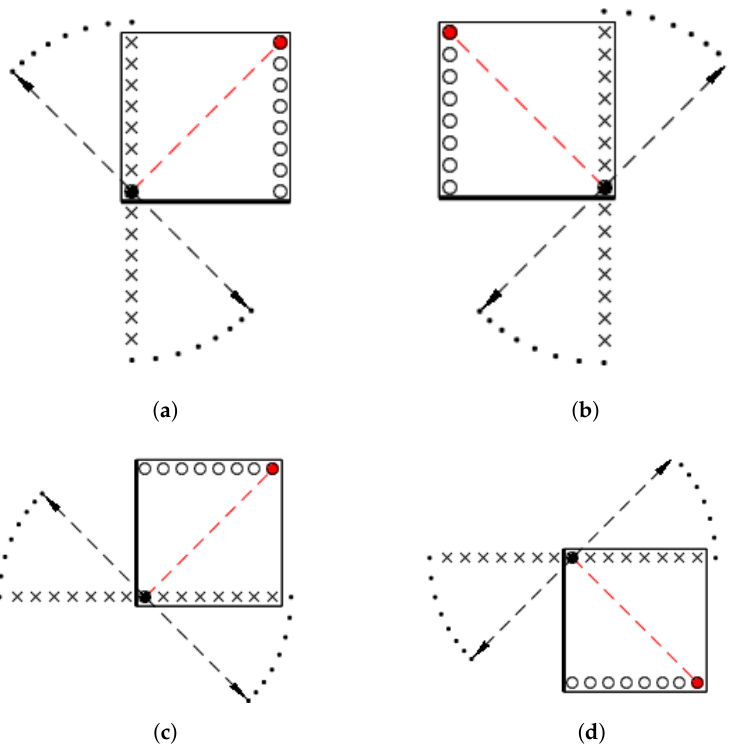
Figure 6. Schemes of behavior of the 4 quadrants of a full DRT. Each quadrant covers 45 ◦ angles of projection. Together they cover all projection angles. ( a ) Quadrant covering 0 ◦ : 45 ◦ angles; ( b ) 135 ◦ : 180 ◦ ≡ 0 ◦ : − 45 ◦ ; ( c ) 90 ◦ : 45 ◦ ; ( d ) − 90 ◦ : − 45 ◦ ≡ 90 ◦ : 135 ◦